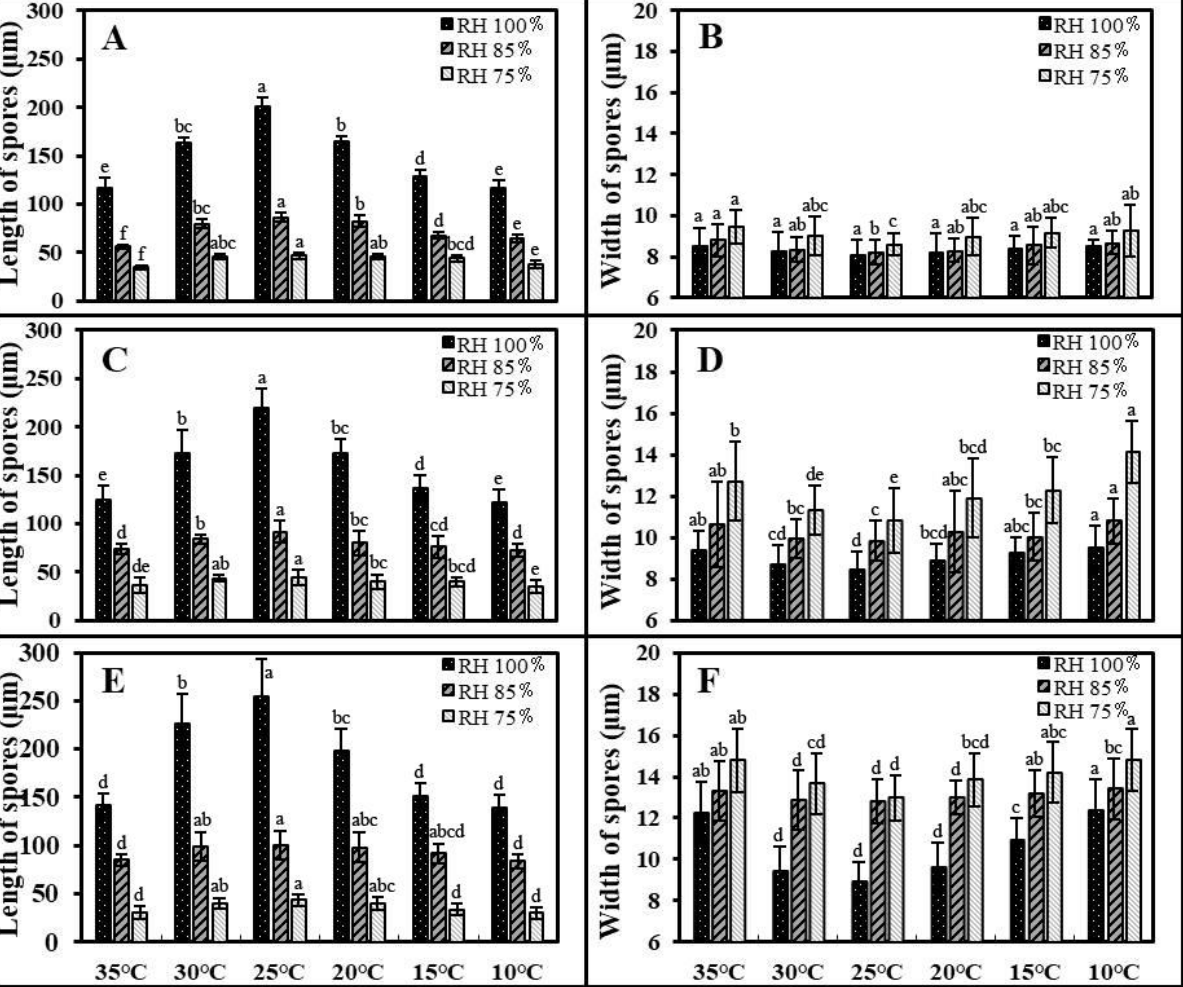
Figure 4. Spore size of Corynespora cassiicola affected by different temperatures and moisture levels on CEA ( A , B ), detached leaves ( C , D ) and cucumber seedlings ( E , F ). Data are means of three experimental repetitions. Bars with different letters are significantly different ( p < 0.05) according to multiple comparisons with Tukey’s